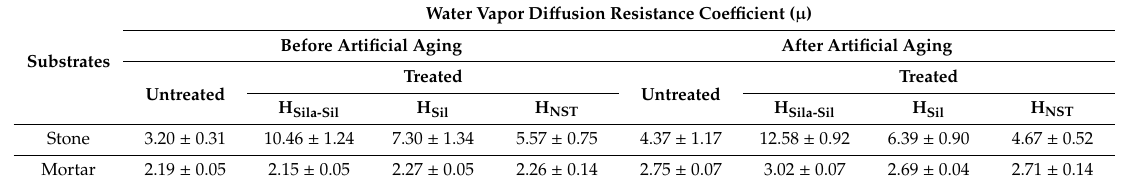
Before Artificial